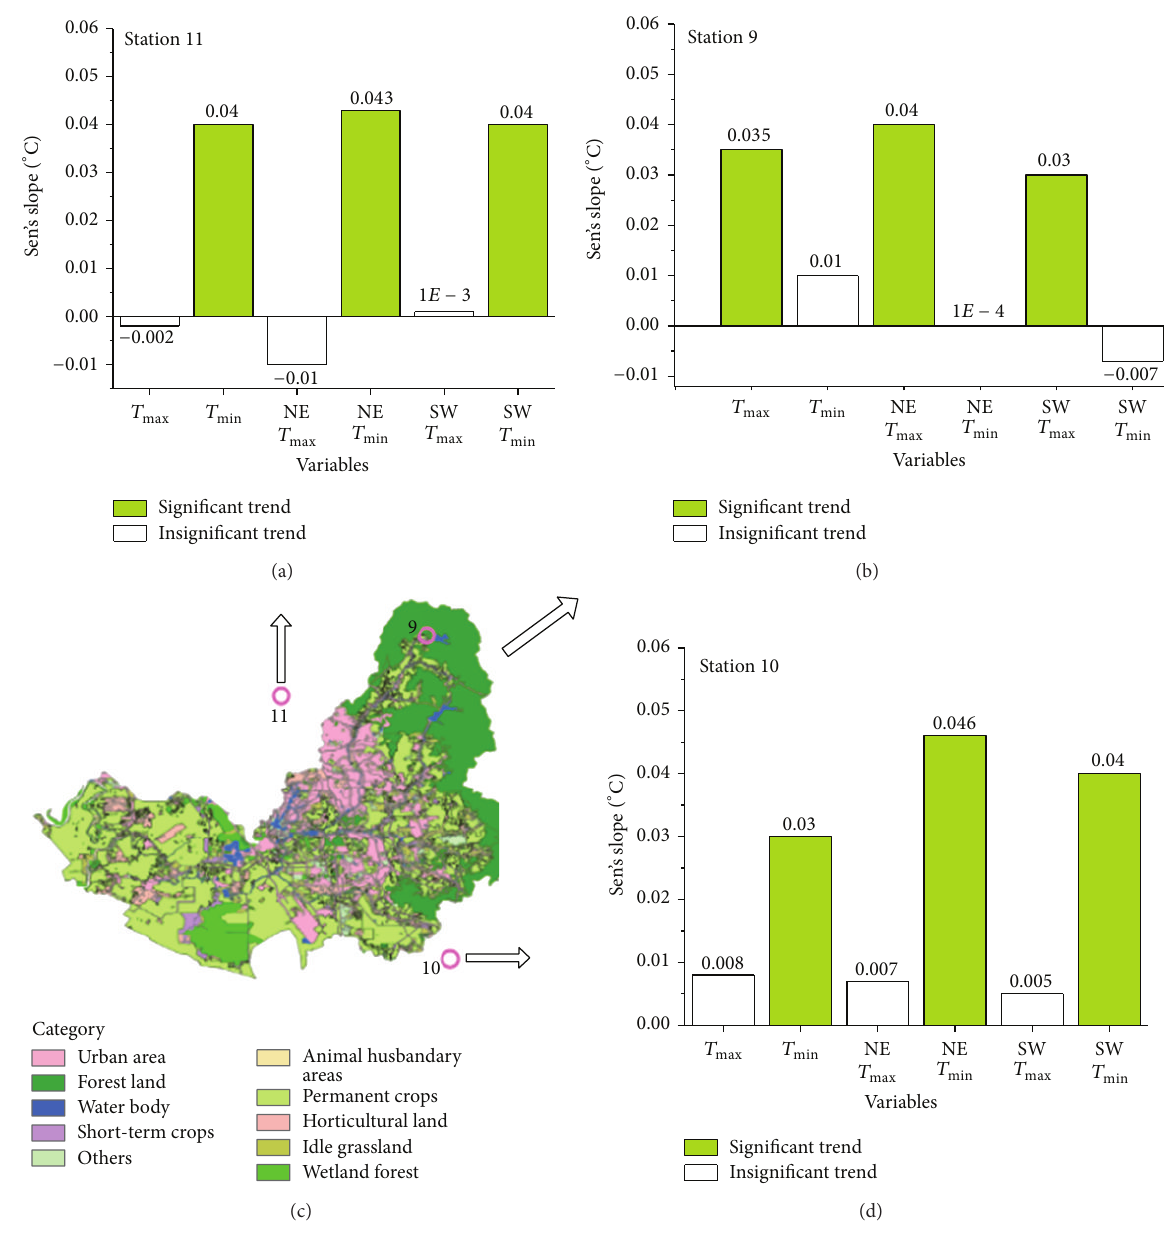
Figure 7: The spatial distribution of significant and insignificant trends for annual and seasonal temperatures along with corresponding Sen’s slope values per